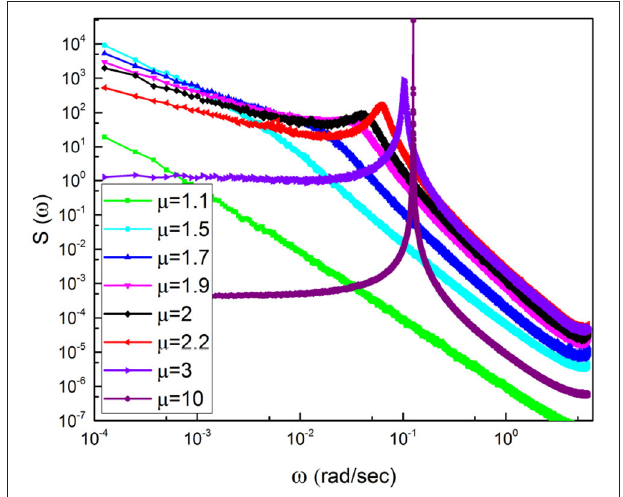
FIGURE 10 | Spectra corresponding to cosine with (cid:127) = 0.77 subordinated to an IPL PDF with a changing µ .